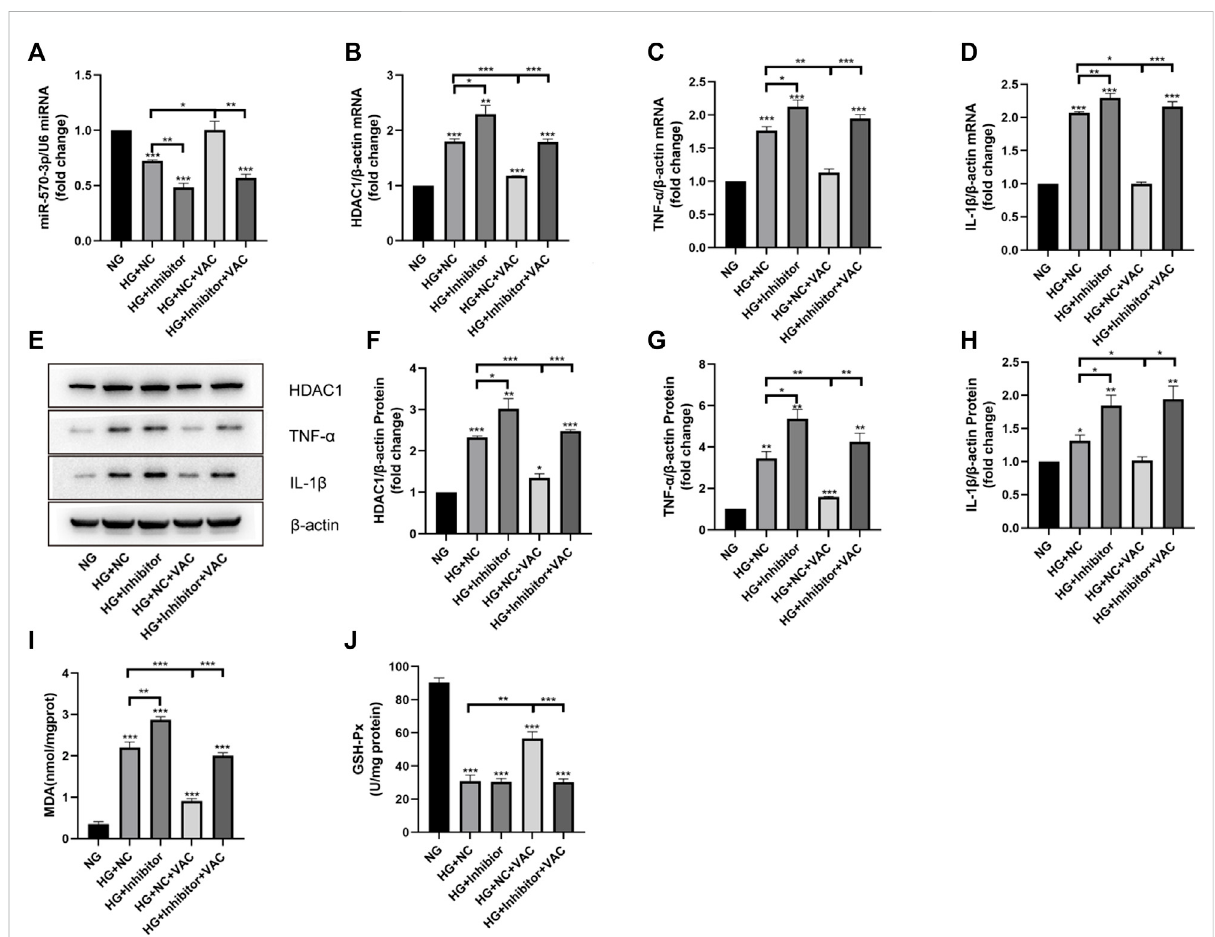
Vaccarin inhibited the expression of HDAC1 and in fl ammatory injury by up-regulating miR-570-3p. (A) . The effects of vaccarin on the expression of miR-570-3p miRNA in HUVEC cells transfected with miR-570-3p NC or miR-570-3p inhibitor. (B – D) . The effects of vaccarin on the expression of HDAC1 mRNA, TNF- α mRNA, and IL-1 β mRNA in HUVEC cells transfected with miR-570-3p NC or miR-570-3p inhibitor. (E – H) . WesternblottinganalysisofHDAC1,TNF- α ,andIL-1 β proteinexpressionlevelsinHUVECcellstransfectedwithmiR-570-3pNCormiR-570-3p inhibitor. Gray value of western blotting. (I) . Content of MDA. (J) . Activity of GSH-Px. Values are mean ± SEM. n = 3 in each group. * p < 0.05, ** p < 0.01, *** p <